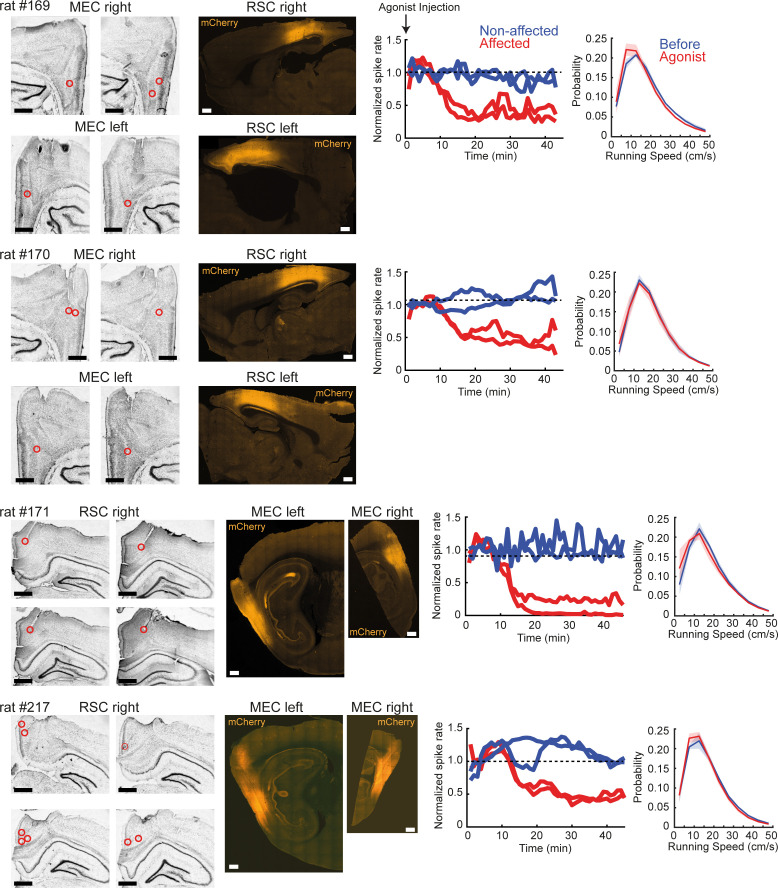
Tetrode locations and hM4Di expression in the experiments of DREADDs-mediated inactivation.Left: Nissl-stained sections and fluorescent images from individual animals used for the DREADDs experiments. In rat #169 and #170, recordings were performed from bilateral MEC and AAV (AAV8-hSyn-hM4Di-mCherry) was injected into the right RSC. Sagittal sections are shown for both Nissl-stained and fluorescent images. Positions of tetrode tracks are indicated by red circles. In rat #171 and #217, recordings were performed from the right RSC, and the AAV was injected into bilateral MEC. Coronal sections are shown for Nissl-stained images, and sagittal sections are shown for fluorescent images. Right two columns: the left plots show normalized firing rates of cells recorded from the virus injected site. The DREADDs agonist-21 was injected at the beginning of the recording sessions. Two red traces show representative cells that exhibited a significant reduction of firing rates after the injection (p<0.05, Wilcoxon ranksum test for rate changes between 0–10 min and 30–40 min), and blue traces are cells that were not significantly affected by the drug. The activity of cells was partly disrupted by the agonist-21 administration, as 70% (14/20) of the recorded cells near the injection site in RSC significantly reduced their firing rates to 53.0 ± 6.4% of their baseline firing, whereas 59% (26/44) of the MEC cells decreased their spiking rate to 47.2 ± 5.5% of baseline. The right plots show the probability density of the animal’s running speed during random foraging in the open field arena, before and after the drug injection. DREADDs-mediated inactivation did not significantly affect the animal’s running speed (p>0.05 in Friedman test). Each plot shows mean (solid lines) and SEM (shaded).